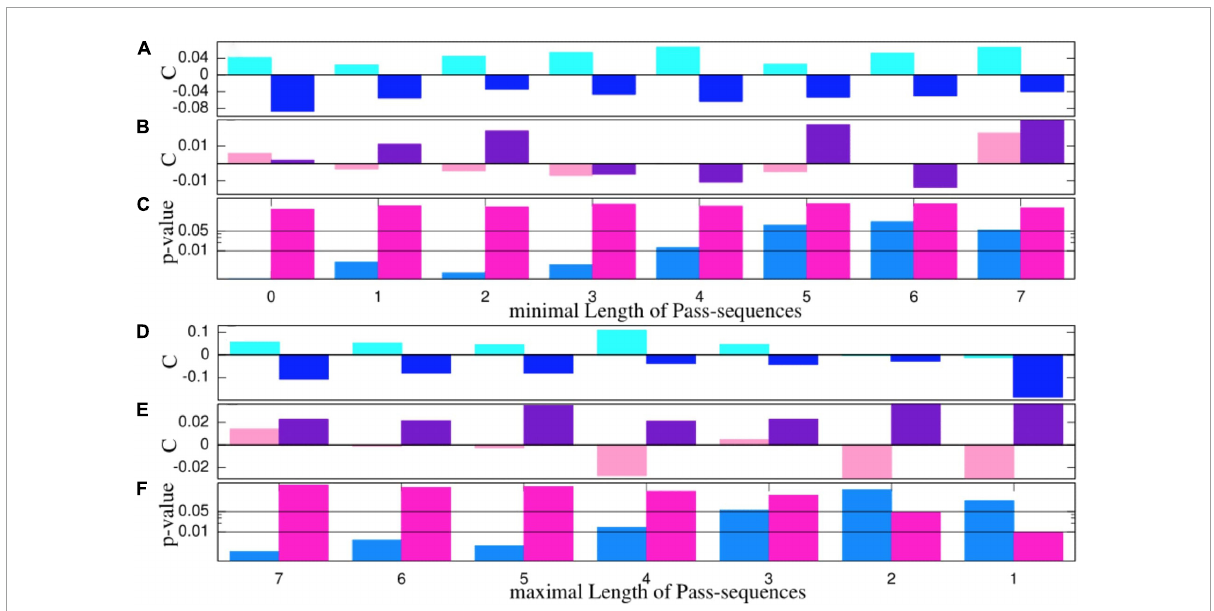
FIGURE2 (A,B,D,E) Medians of relative connectivity values normalized to those estimated from the thirds without cRAS. Blue colors refer to male and pink color to female teams. Light pink/blue refers to the Sy-condition and dark pink/blue to the nS-condition. Panels (C,F) display the p -value on a logarithmic scale estimated by Mann-Whitney-Wilcoxon rank test, which provides the probability that the samples obtained for the Sy- and nS-modes stem from the same distribution. Horizontal black lines in panels (C,F) indicate the 1 and 5% significance level, respectively. The abscissa in panels (A–C) and (D–F) mark the minimal (maximal) length of pass sequences considered.